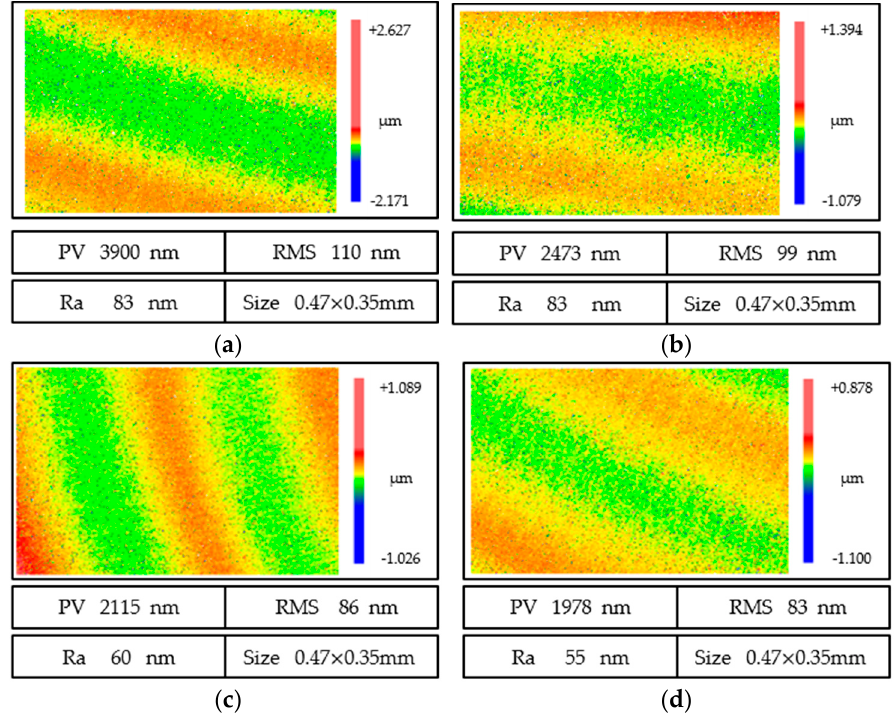
Figure 13. Surface quality evolution of ground fused quartz at different cutting speeds. ( a ) V c = 17.8 m/s. ( b ) V c = 21.9 m/s. ( c ) V c = 26.2 m/s. ( d ) V c = 30.4 m/s.